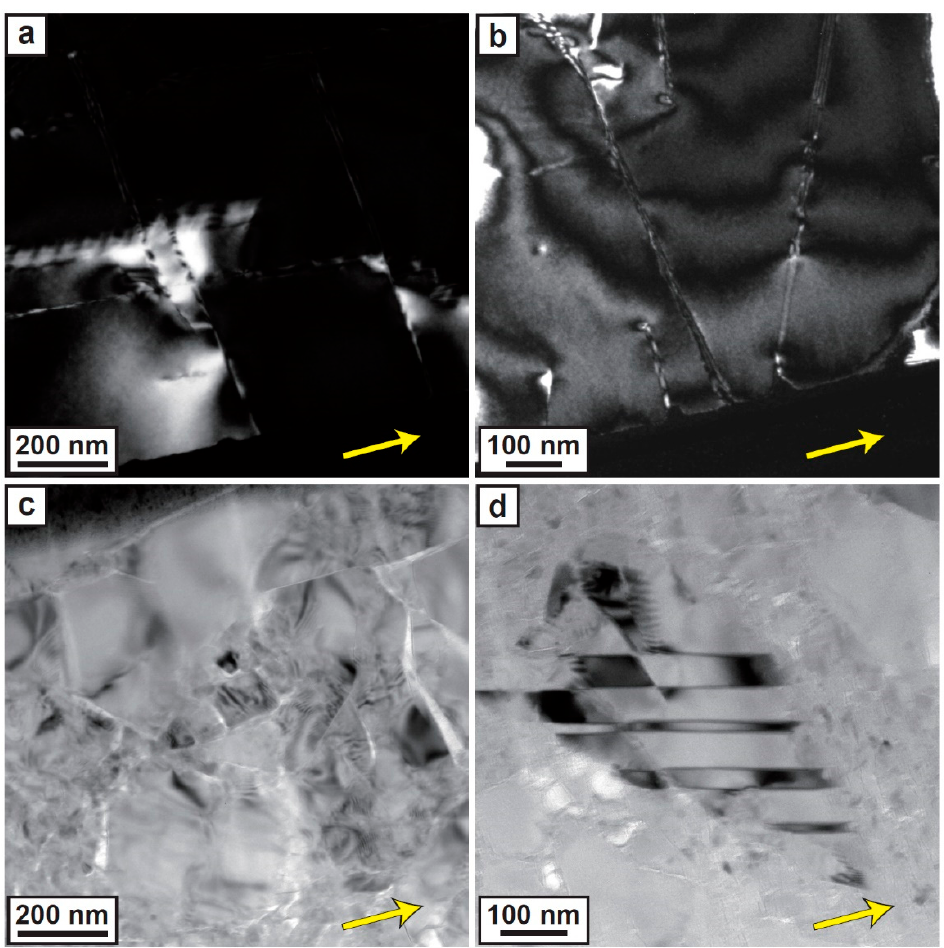
Figure 8. ( a , b ) Weak-beam dark field (WBDF) images of epidote experimentally deformed under a shear strain of γ = 2.4 at P = 1.5 GPa and T = 500 °C (JH98a); ( c , d ) bright-field (BF) images of epidote experimentally deformed under a high shear strain of γ = 4.5 at P = 1.5 GPa and T = 400 °C (JH94a). Yellow arrows indicate the shear direction in the images. P: pressure; and T: temperature.